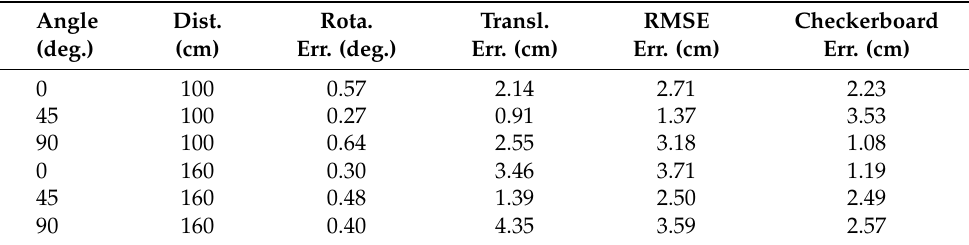
Table 2. Human motion-based calibration is compared with the standard checkerboard calibration for each of the tested setups. Differences between the resulting transformations are given (see text). The measurement error of the checkerboard calibration method is also given. Angle Dist. Rota. Transl. RMSE Checkerboard (deg.) (cm) Err. (deg.) Err. (cm) Err. (cm) Err. (cm) 0 100 0.57 2.14 2.71 2.23 45 100 0.27 0.91 1.37 3.53 90 100 0.64 2.55 3.18 1.08 0 160 0.30 3.46 3.71 1.19 45 160 0.48 1.39 2.50 2.49 90 160 0.40 4.35 3.59